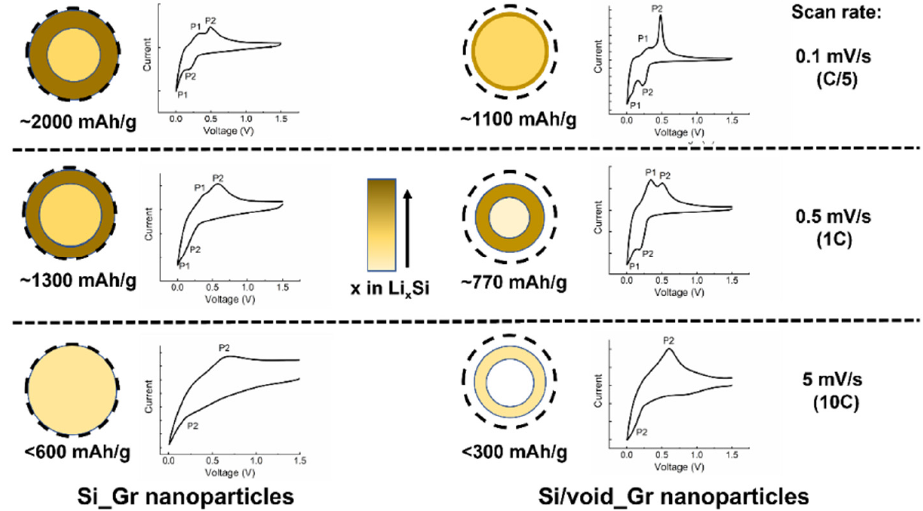
Figure 6. Schematic representation of the lithiated state at 0 V for Si_Gr and Si/void_Gr nanoparticles at various scan rates (and related C rates) with the corresponding voltammograms. The thickness of the various alloys, nanoparticles and voids is not to be considered as accurately defined.